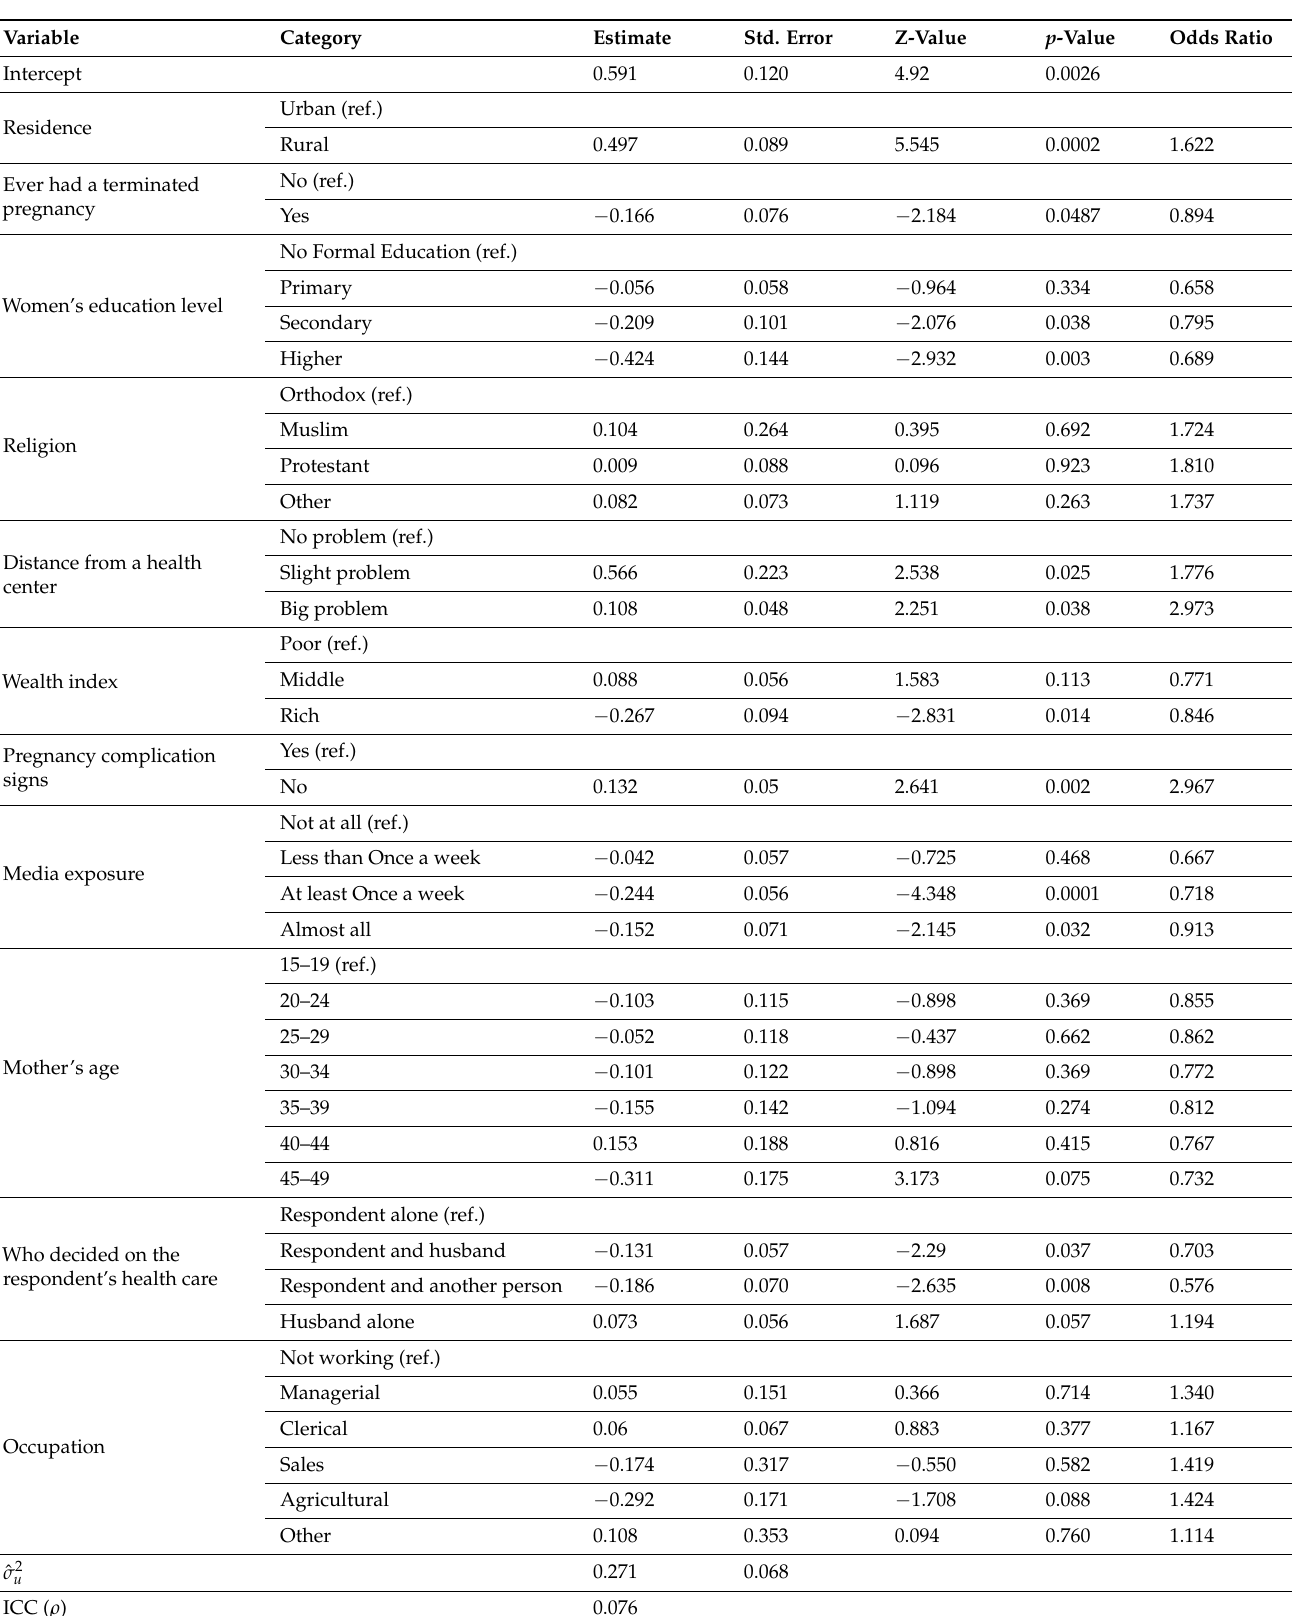
Table 3. Result of the classical multilevel